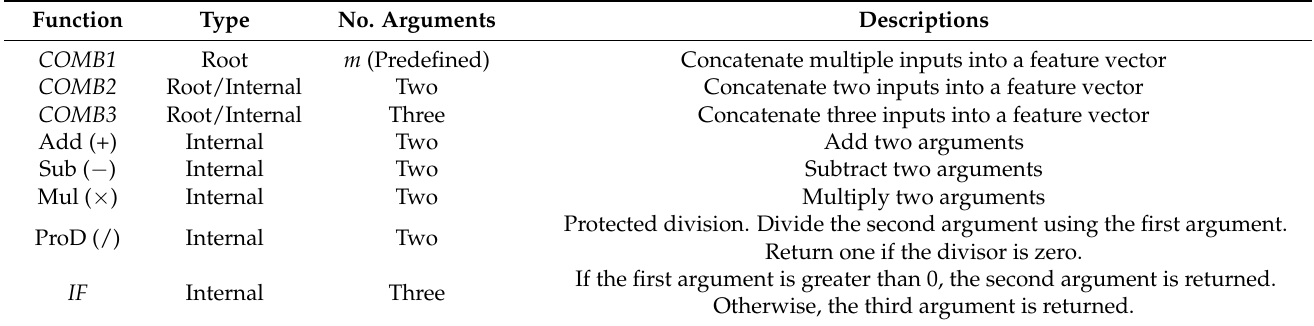
Table 1. The function set of the proposed